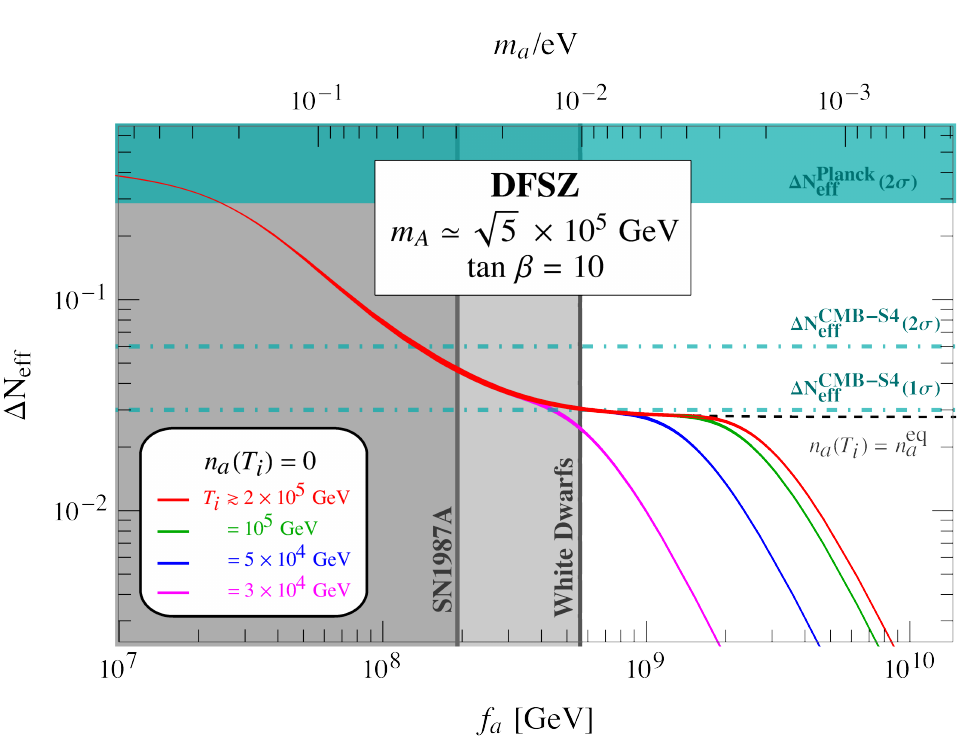
Figure 11 . Contribution to ∆ N eff as a function of the axion decay constant f a for the DFSZ